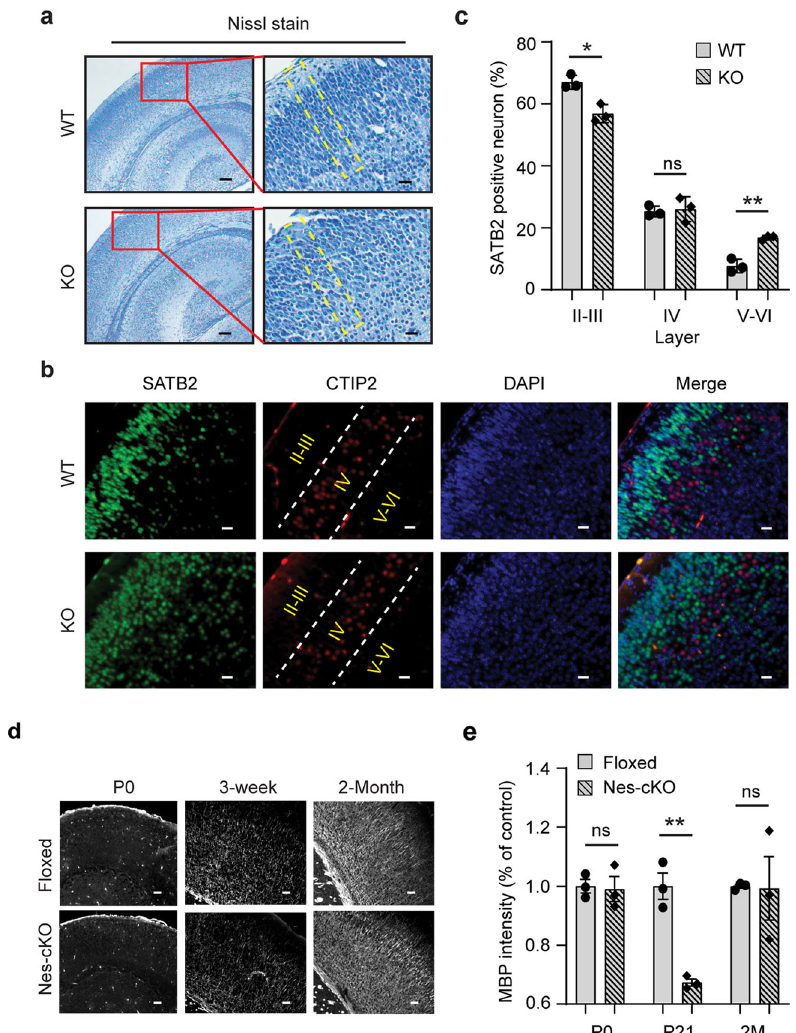
Fig. 2 Loss of ASH1L delays embryonic and postnatal brain development. a Nissl staining showing the cortical histology of wild-type and global Ash1L- KO newborns. The mini-columnar arrangement of cortical cells is highlighted by yellow lines. Bar (left) = 100 µ m, Bar (right) = 20 µ m. b Photos showing the distribution of L2/3-speci fi c SATB2 + cells and L4-speci fi c CTIP2 + cells in wild-type and Ash1L -KO cortices at P0, bar = 20 µ m. c Quanti fi cation of SATB2 + neurons in different layers. For each group, n = 3 biologically independent samples. P- values calculated using a two-tailed t test. Error bars in graphs represent mean ± SEM. Note: * p < 0.05; ** p < 0.01; ns, not signi fi cant. d Photos showing the myelin basic protein (MBP) staining of P0, P21, and postnatal 2-month cortices, bar = 100 µ m. e Quantitative MBP expr e ssion analyzed by the integrated fl uorescence intensity in cortices. Values are percentage of control values ± SEM. For each group, n = 3 biologically independent samples. P- values calculated using a two-tailed t test. Note: ** p < 0.01; ns, not signi fi